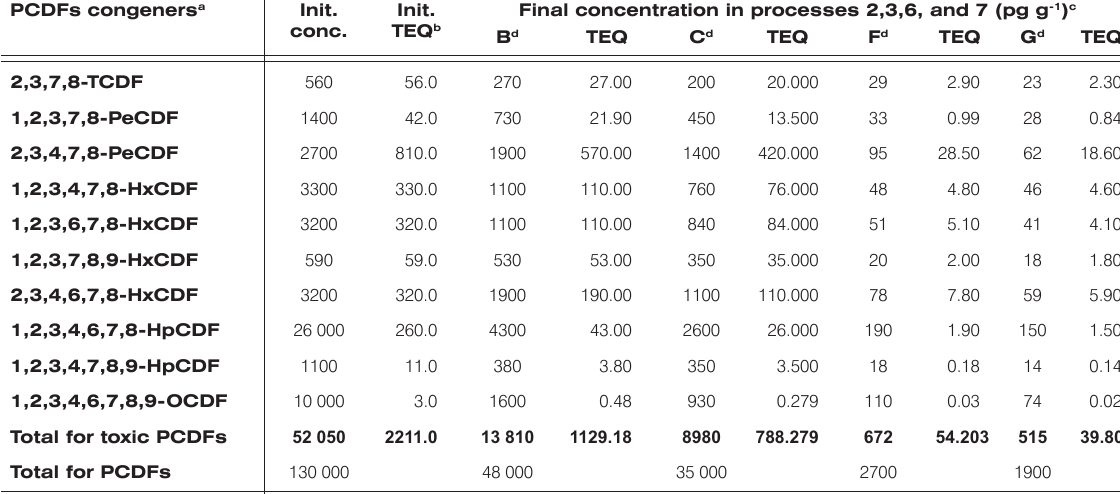
Table 3. Concentrations and TEQs of PCDFs congeners, prior to and after treatment. PCDFs congeners a Init.